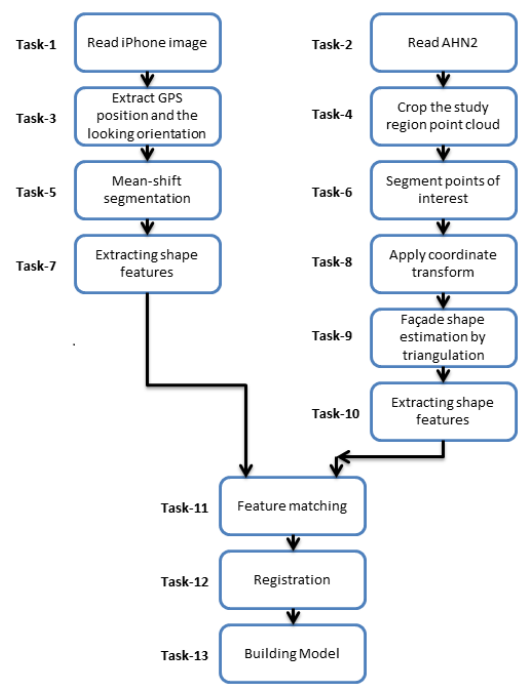
Figure 1: The proposed work flow chart.